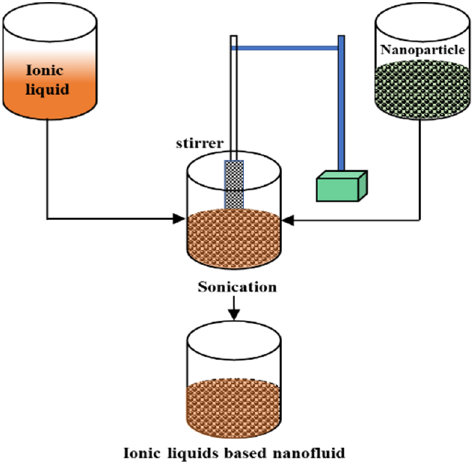
Figure 3. Schematic of two-steps method of ILs-based nanofluids preparation. Table 1 represents all the studied base ILs, while Table 2 represents the summary of studied ILs-based nanofluids with their nanoparticles concentrations. Table 1. List of the studied ionic liquids.